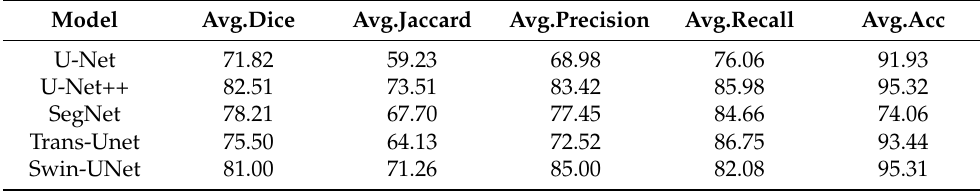
Table 6. Segmentation performance of models of five-fold cross-validation experiment on the test set.